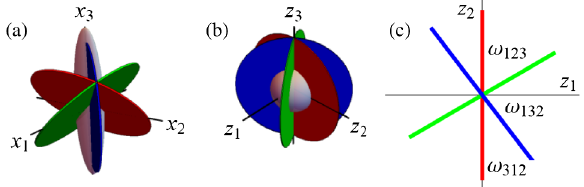
FIG. 5. Coordinate transformation for three particles with the A 2 masses m 1 ¼ 1 = 13 M , m 2 ¼ 9 = 52 M , and m ¼ 3 = 4 M , where M is the total mass. (a) Configuration space in natural particle positions x . The gray ellipsoid represents an equipotential for the equal frequency (and therefore not equal strength), and the red, green, and blue disks represent the X 12 , X 23 , and X 31 coincidence planes, respectively. (b) Configuration space in mass-scaled and rotated coordinates z ¼ J x , with a spherical equipotential and transformed coincidence planes Z 12 , Z 23 , and Z 31 . (c) Projection of structure in (b) into relative coordinate z 1 − z 2 plane. The sector with angle ω 123 ¼ π = 3 is the Coxeter